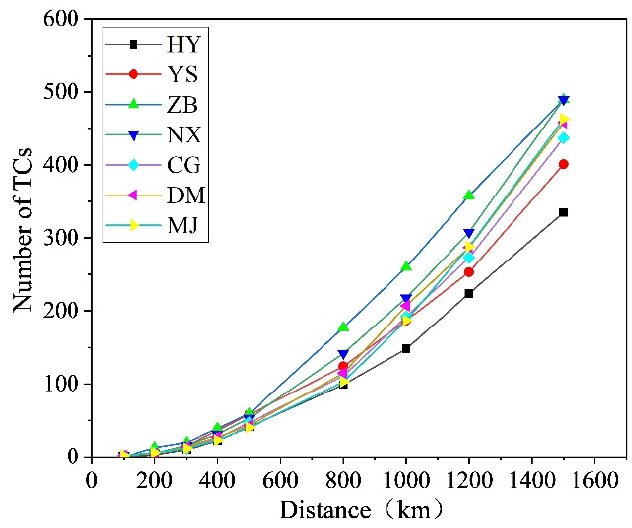
Figure 9. Numbers of TCs at different distances (between TCs’ centers and islands).